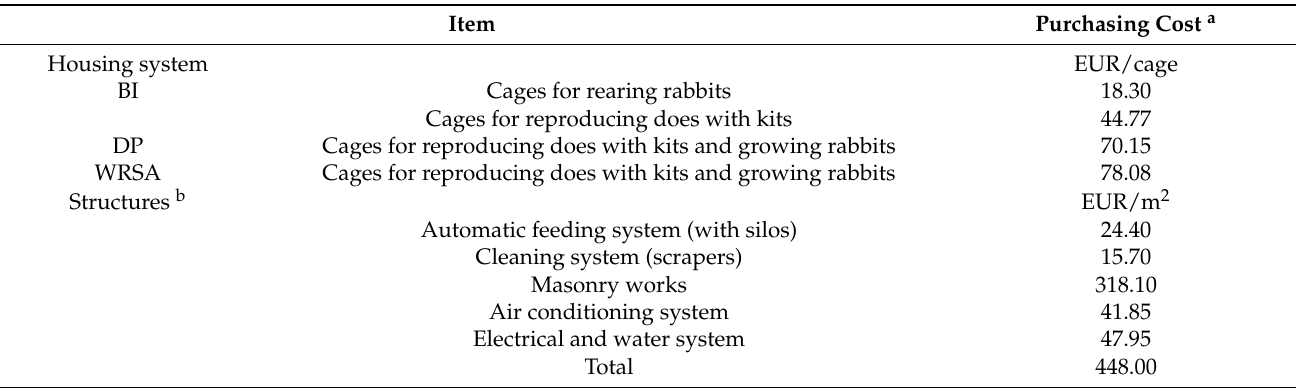
Table 2. Estimated purchasing costs for different type of cage and